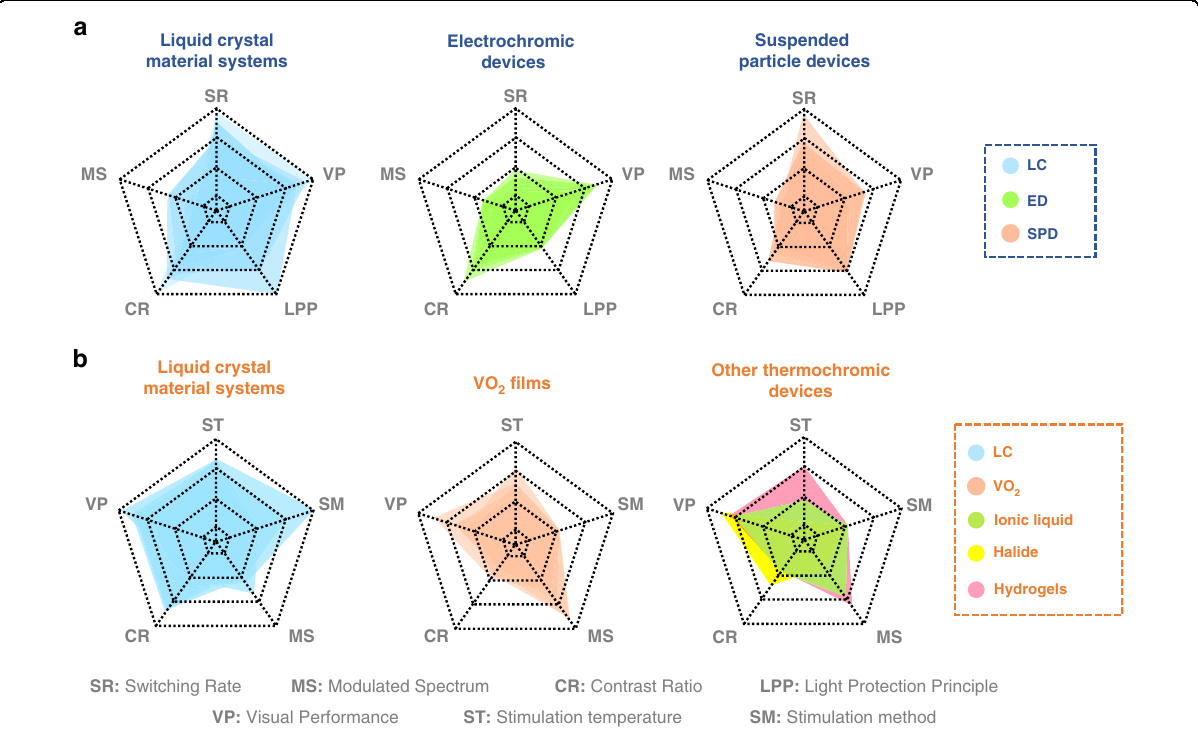
Fig. 2 Comparison of the performance of light protection techniques for different stimulus types. a Optical performance and response time of different electronically controlled optical devices, where different colors indicate different material types 15,19,171,195 – 197,200,203,204,207,211 – 215 . b Optical performance and stimulus temperature of different temperature-controlled optical devices, where different colors indicate different material types 171,178,180 – 182,184,216 –